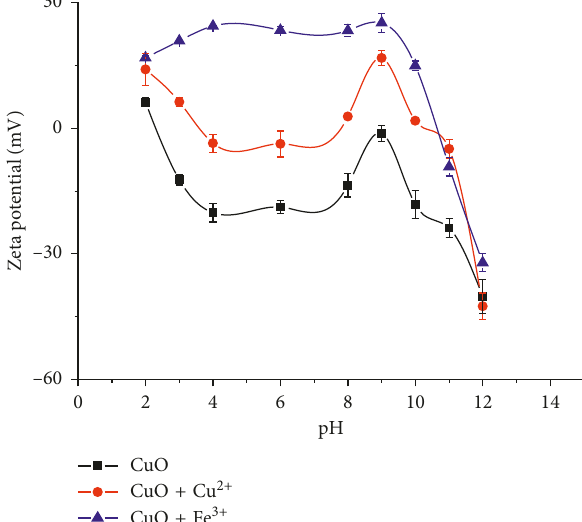
Figure 4: Effect of Cu 2+ and Fe 3+ ions on the zeta potential of CuO.